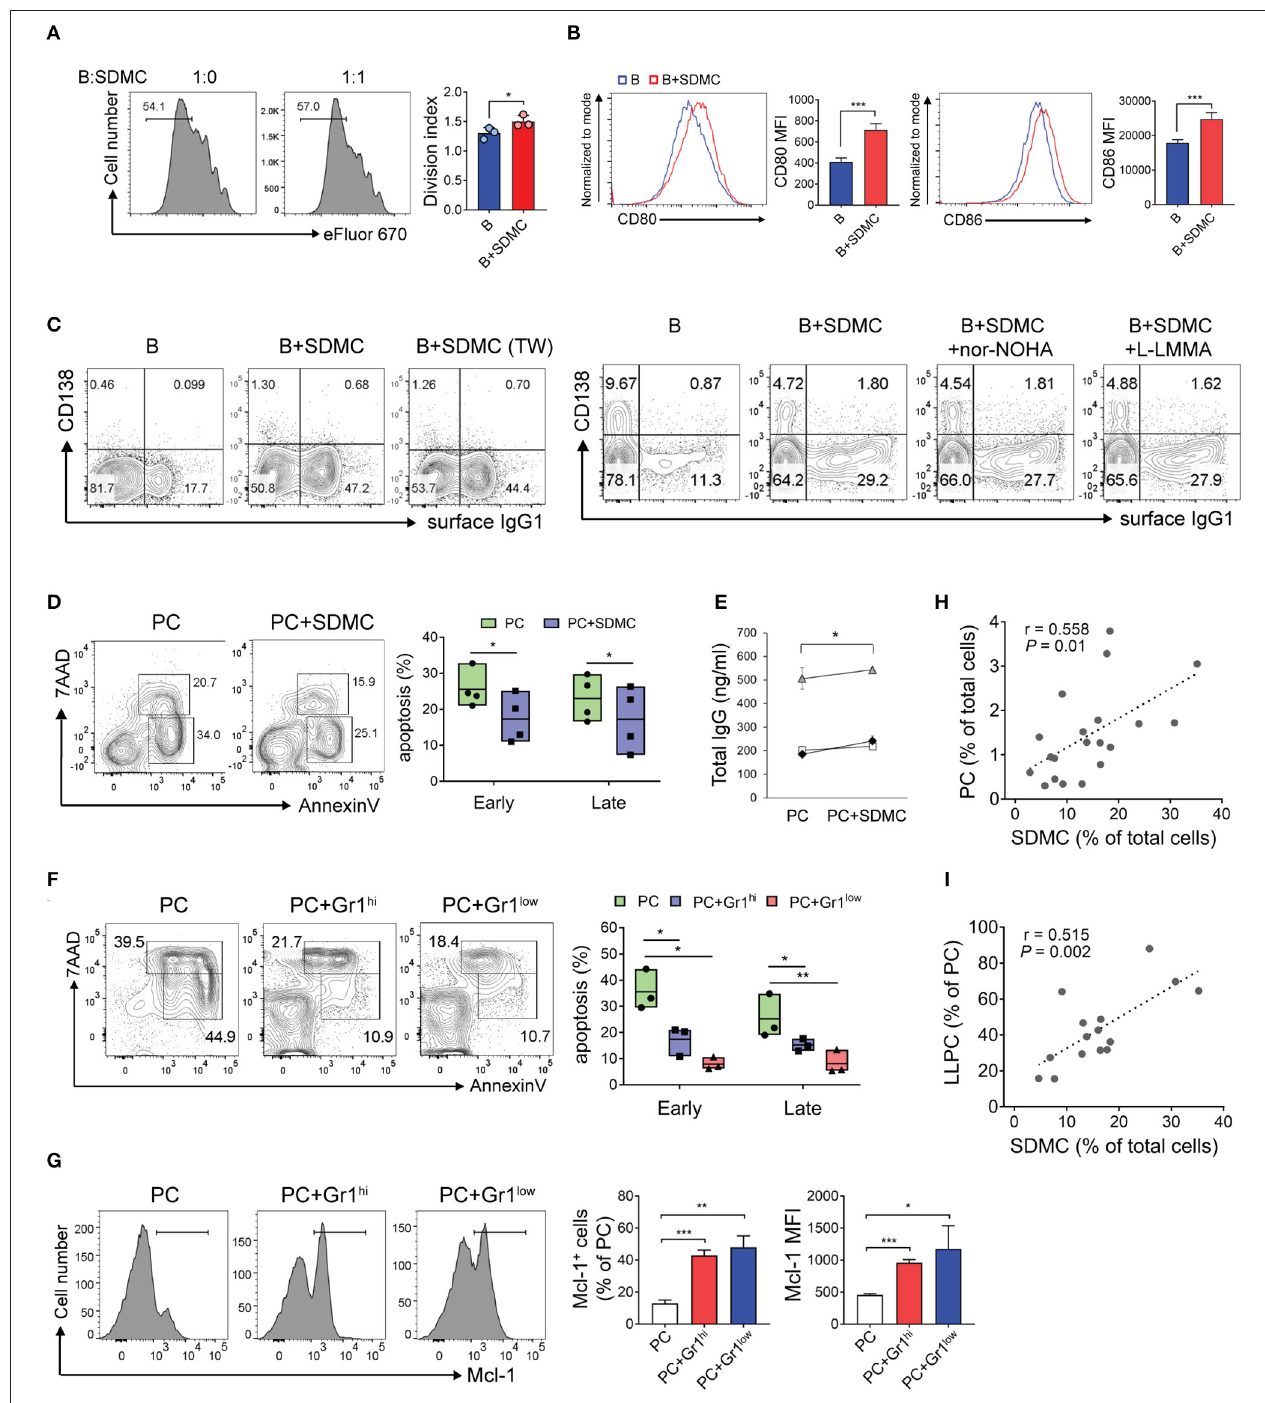
FIGURE 5 | Effects of SDMCs on activation of B cells and survival of PCs. (A–C) CD19 + B cells from C57BL/6 mice were stained with eFluor 670 (A) or unstained (B,C) . They were then stimulated with LPS and IL-4 in the absence or presence of SDMCs from sanroque mice, transwells (TW), or inhibitors, as indicated, and assayed by FACS. Ratios of B cells: SDMCs were 1:1 (A) and 2:1 (B,C) . (D) PCs from sanroque mice were cultured with or without SDMCs at a ratio of 2:1 for 48h and assayed by FACS gated on PCs to detect apoptotic PCs. Floating bars (min to max, line at mean) represent percentages of apoptotic PCs. (E) Supernatants were assayed by ELISA to detect IgG. Results from 3 independent experiments are shown. (F,G) CD11b + Gr-1 hi and CD11b + Gr-1 lo subsets of SDMCs were separately sorted and co-cultured with PCs as in (D) . FACS profiles gated on PCs and plots displayed as means ± SDs are shown. (H,I) Sanroque mice were assayed by FACS to measure percentages of PCs, SDMCs and long-lived PCs in spleens, followed by correlation analysis. The data are representative of more than 3 independent experiments. * p < 0.05, ** p < 0.01, and *** p < 0.001 by paired (E) or unpaired [all except (E)] Student’s t -tests.